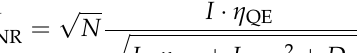
. Figure 7f–h show the re-